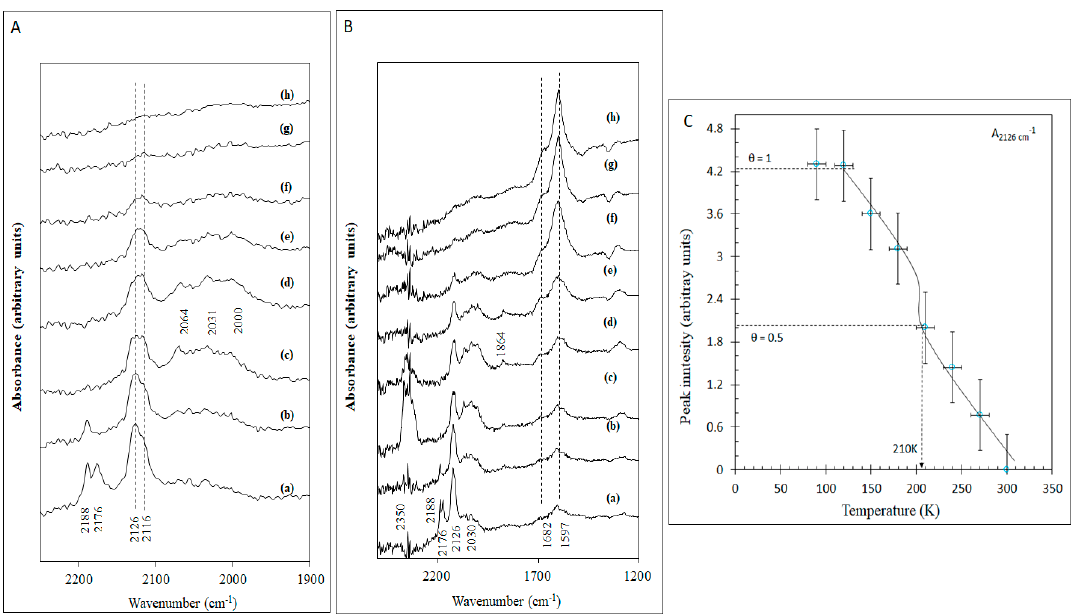
Figure 8. ( A ) FT-IR spectra of CO adsorbed on Rh/CeO 2 in the 2250–1900 cm − 1 region at (a) 90 K, (b) 120 K, ( c ) 150 K, (d) 180 K, (e) 210 K, ( f ) 240 K, (g) 270 K, and (h) 290 K. ( B ) A FT-IR spectra of CO adsorbed on Rh/CeO 2 in the 2500–1200 cm − 1 region at (a) 90 K, (b) 120 K, (c) 150 K, (d) 180 K, (e) 210 K, (f) 240 K, (g) 270 K, and (h) 290 K. ( C ) Peak intensity of the ν CO at 2126 cm − 1 as a function to temperature, the coverage, ν , is taken as equal to 1 at 90 K.